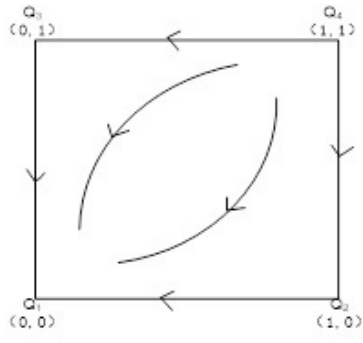
Fig. 2 Phase evolution diagram in scenario